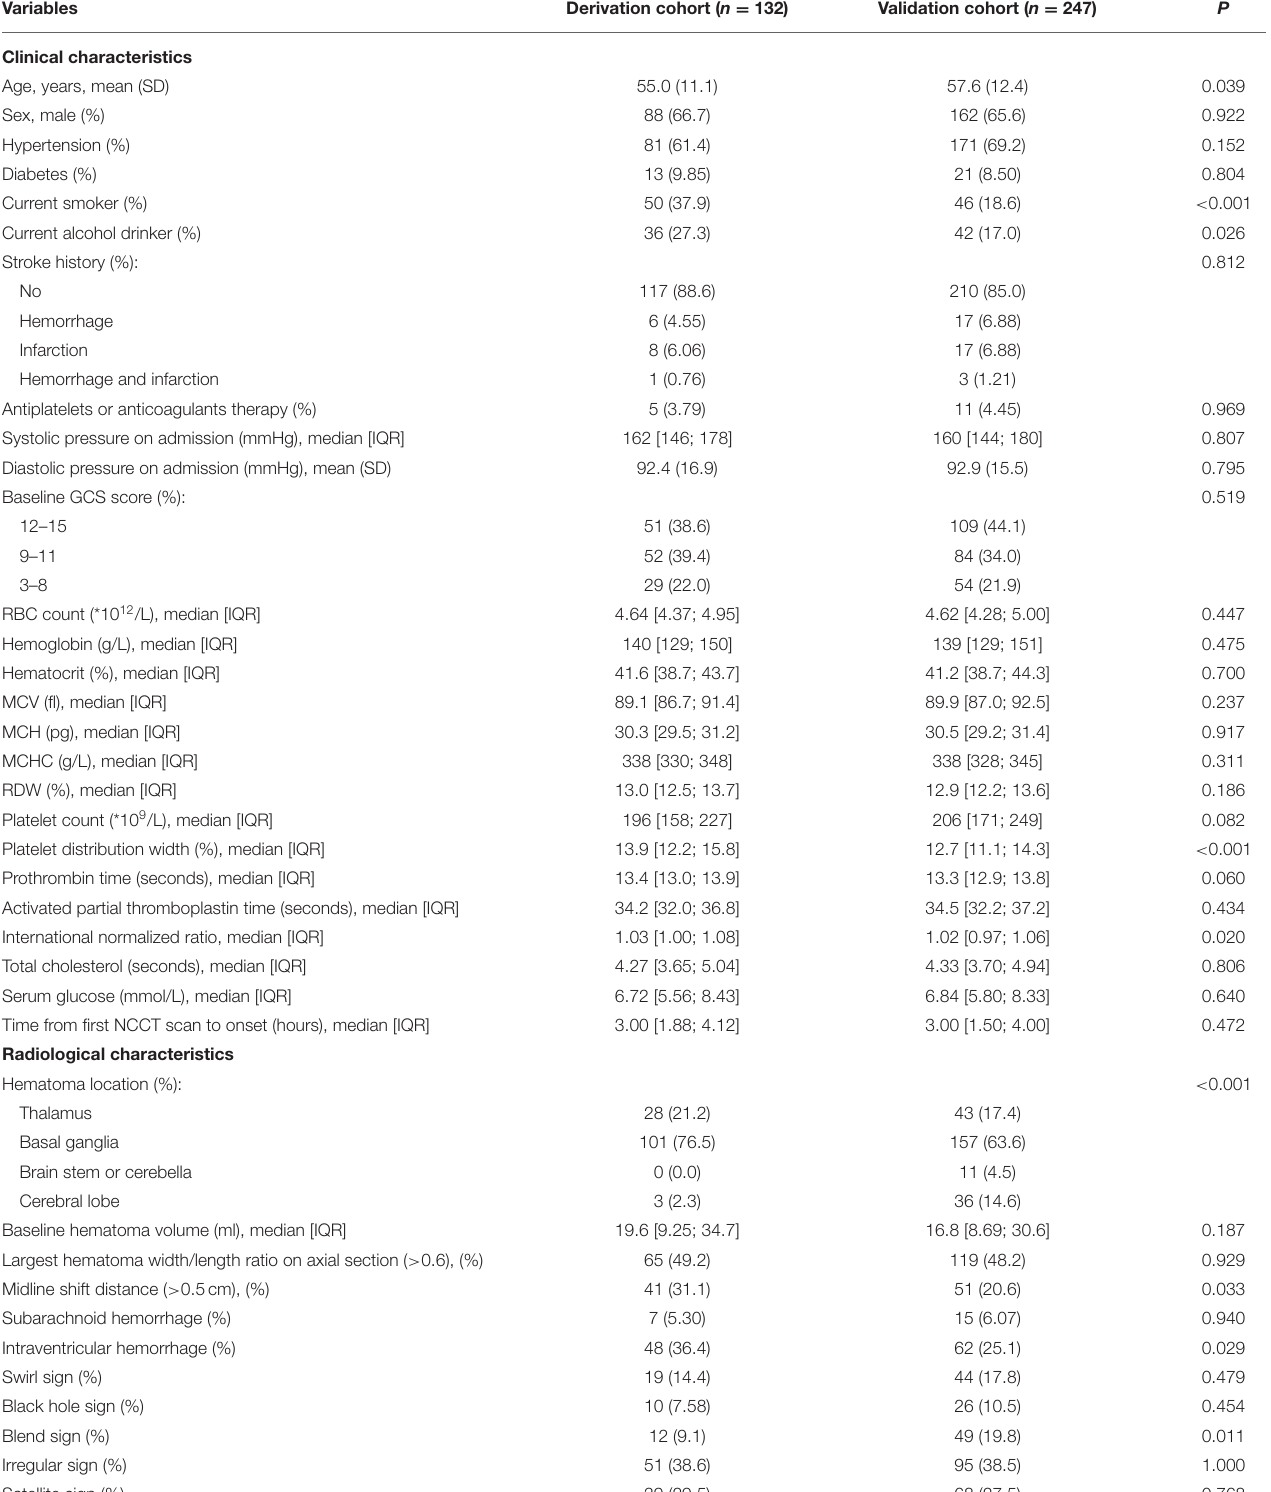
TABLE 1 | Comparison of clinical and radiological characteristics and the outcome of derivation and validation cohort patients. Variables Derivation cohort ( n = 132) Validation cohort ( n = 247) P Clinical